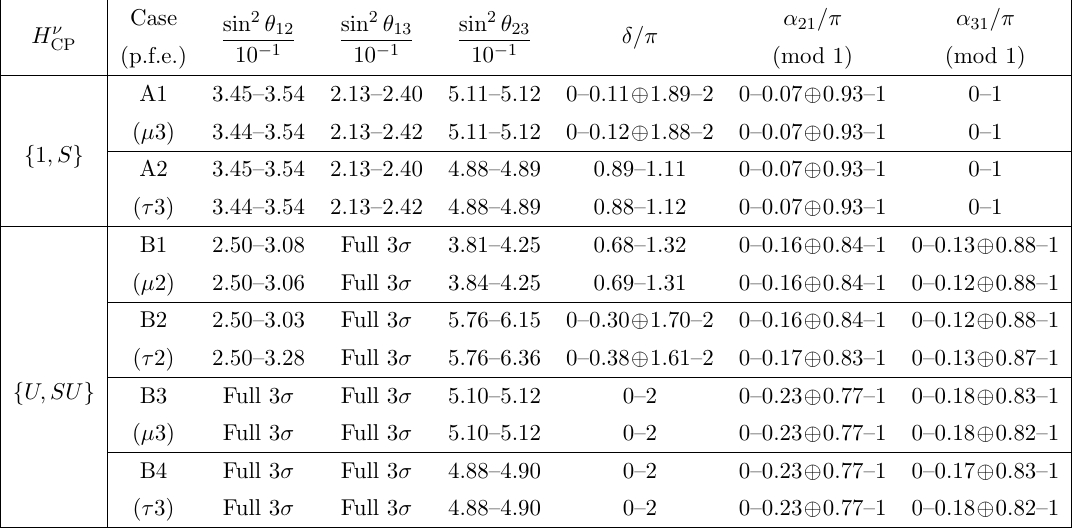
Table 3 . Ranges of the mixing parameters for the viable cases, i.e., those cases for which the predicted values of all the three mixing angles lie inside their respective 3 (cid:27) allowed ranges. The cases presented here correspond to G e = Z g e which the magnitude of the (cid:12)xed element is 1 = case, the upper and lower rows refer to NO and IO, respectively.